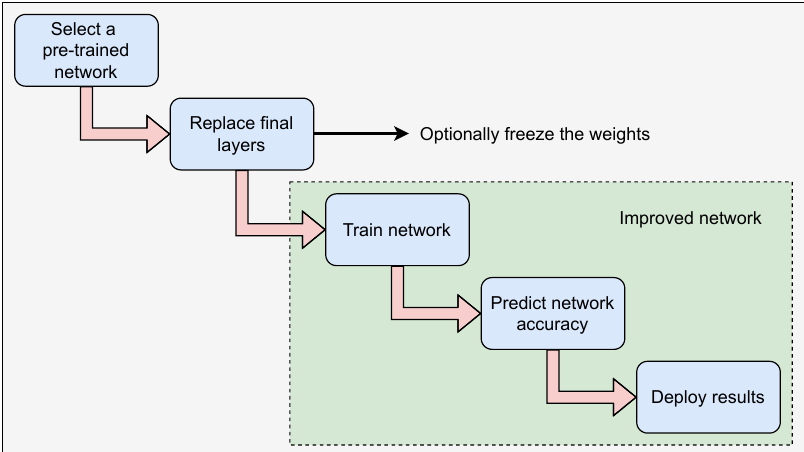
Figure 3. Classification with pre-trained deep